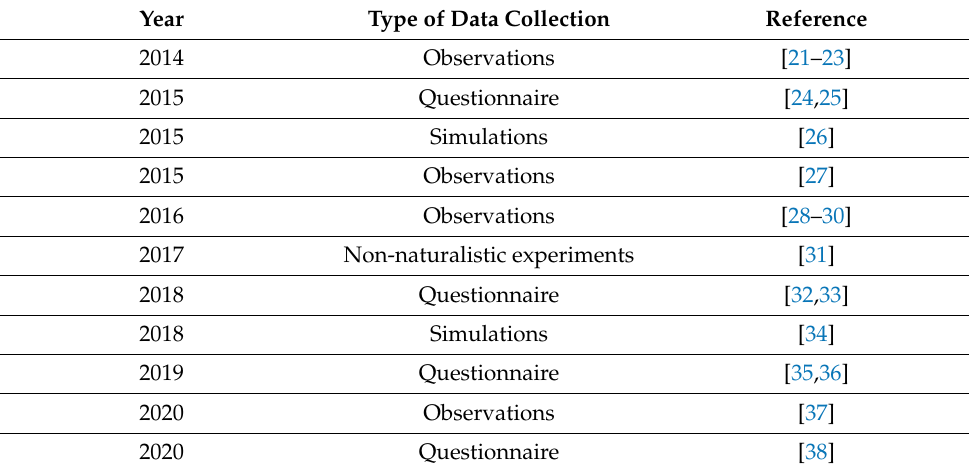
Table 1. Data collection procedures in